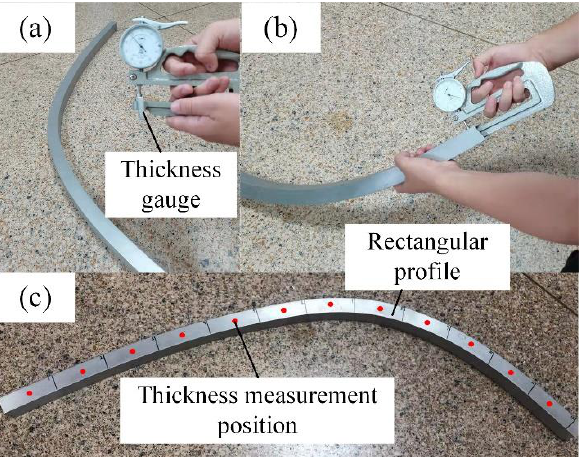
Figure 9. Thickness measurement experiment: ( a ) the thickness gauge, ( b ) the method of operation, ( c ) Display of divided areas and measuring points.